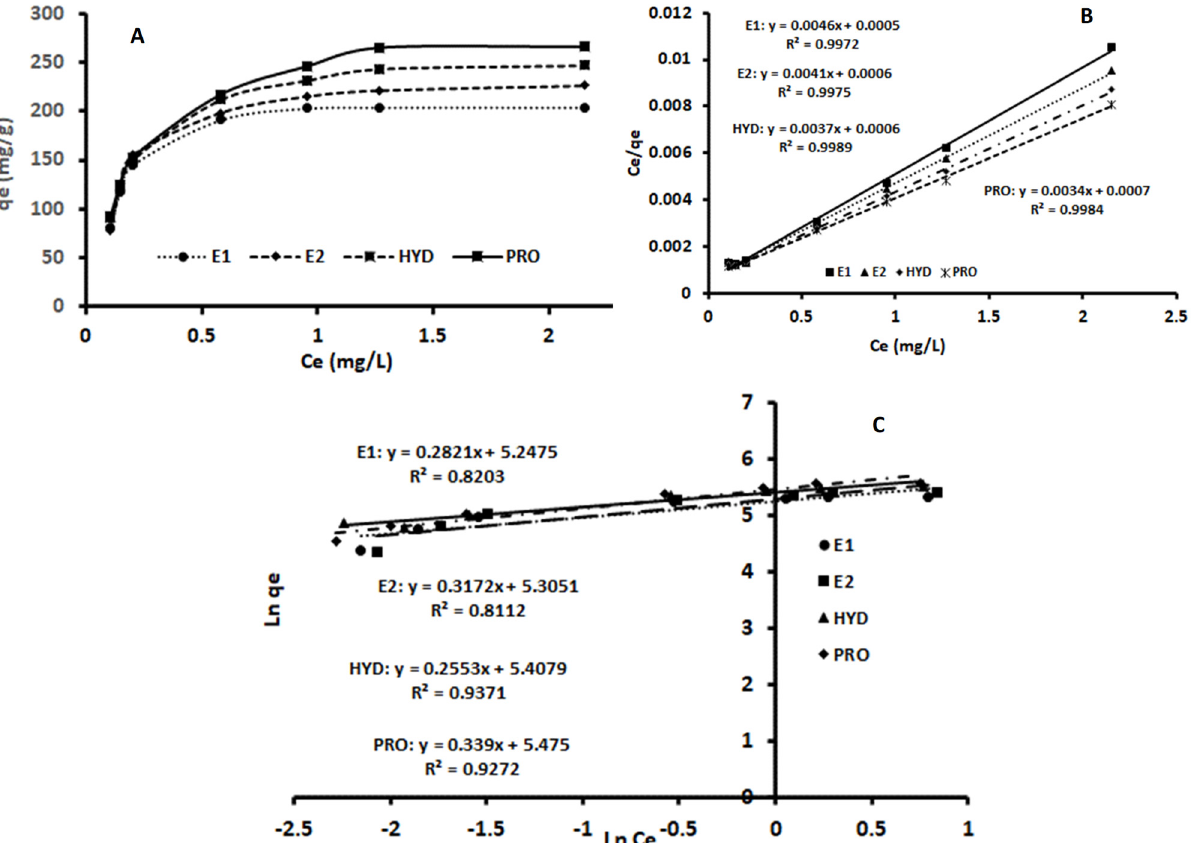
Figure 8. Plots of C e /q e against C e ( A ), and ln q e versus ln C e , for Langmuir ( B ) and Freundlich ( C ) models. Table 6. Langmuir and Freundlich adsorption models and parameters investigated in the study.